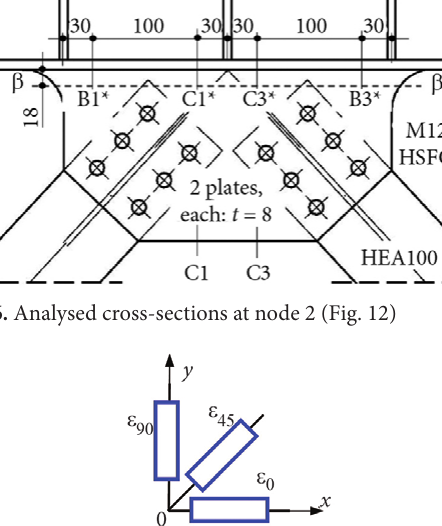
Fig. 17. Scheme of a rosette on twin gusset plates at B1*, C1*, C3*, B3*; ε 0 , ε 45 , ε 90 denote measured strains Table 1. Normal stress parallel to bracing members Location